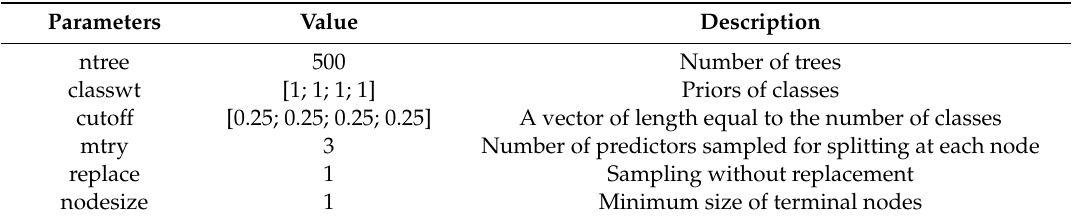
Table 5. The parameters of the prediction model (the RF algorithm).